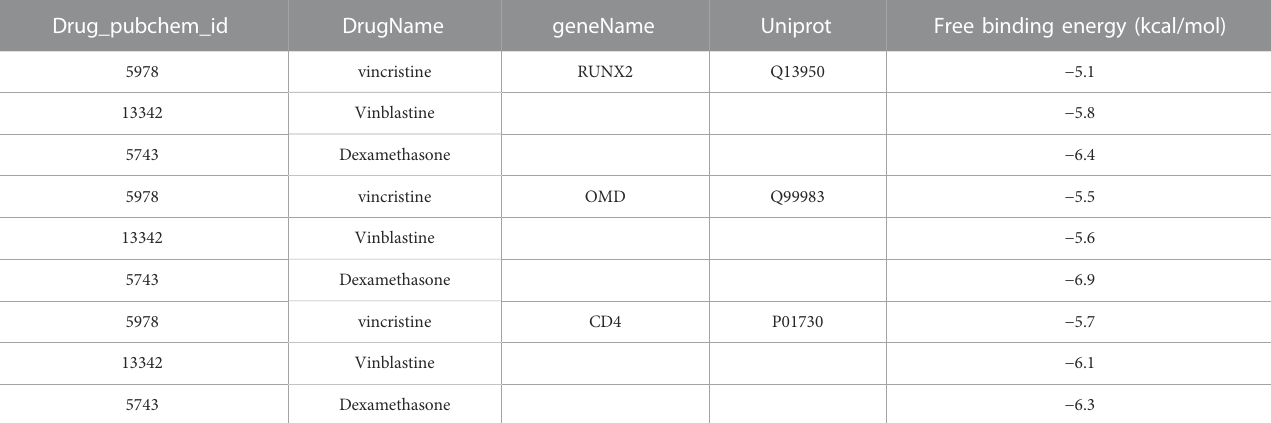
TABLE 3 The information of molecular docking.